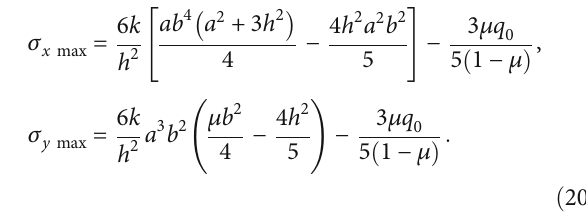
Figure 5: Distribution characteristics of stress σ and (b) planar distribution of the stress σ y